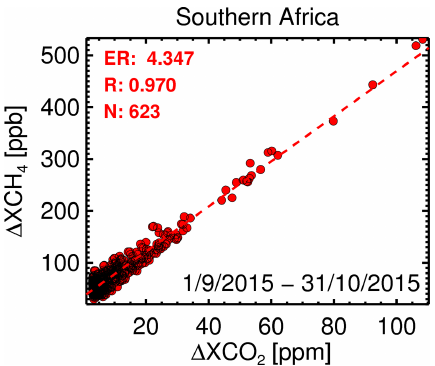
Figure B1. Scatterplot showing the (cid:49) XCH 4 vs. (cid:49) XCO 2 values, calculated as the difference between the values in the fire-affected soundings to those in the background cases over the entire southern African region from 1 September to 31 October 2015. The CH 4 / CO 2 ER is calculated from the gradient of the linear best fit, which is shown along with the correlation coefficient R and the number of sounding pairs N . This GOSAT-derived ER is very similar to the fire-averaged CH 4 to CO 2 ER of 4.3 ± 1.7ppbppm − 1 derived by Wooster et al. (2011) using open-path FTIR spectroscopy measurements close to the source on these types of savannah fire events.